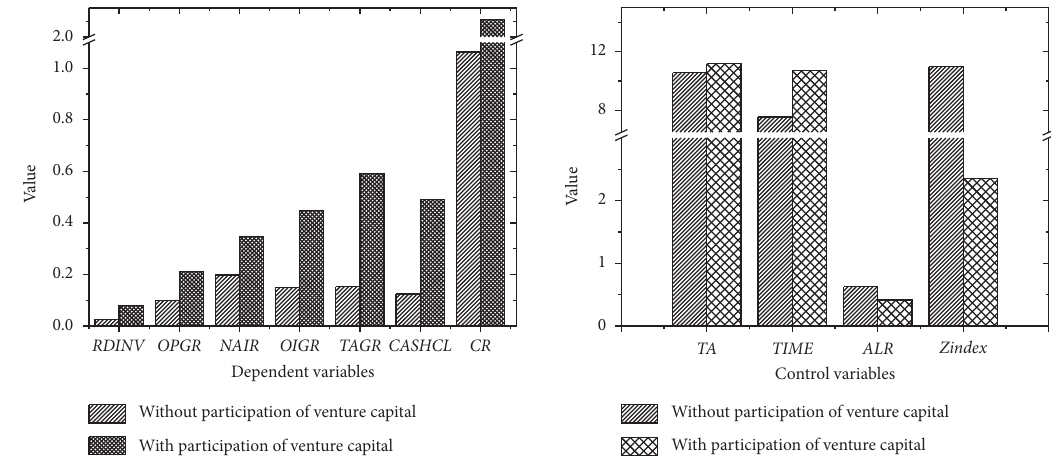
Figure 2: The mean value comparisons of development indicators of SMEs with or without venture capital.